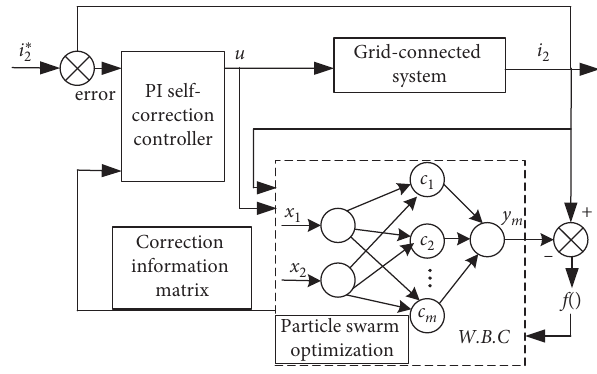
Figure 8: Block diagram based on PSO_RBF network adaptive controller.